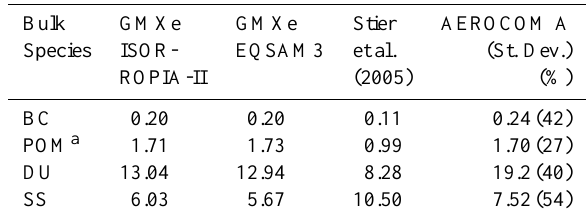
Table 4. Budget of the bulk species compared to values reported for the M7 within the ECHAM-HAM model (Stier et al., 2005) and the AEROCOM multi-model inter-comparison (Textor et al., 2006). The standard deviation of reported AEROCOM values is given in brackets.